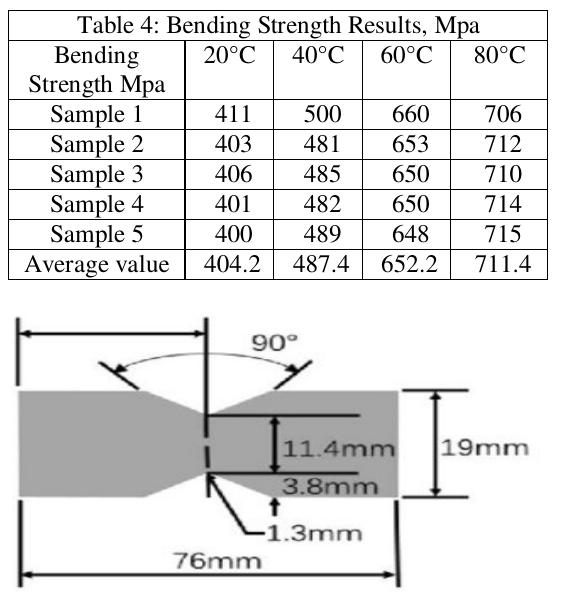
Fig 5: Specimen for Shear Test